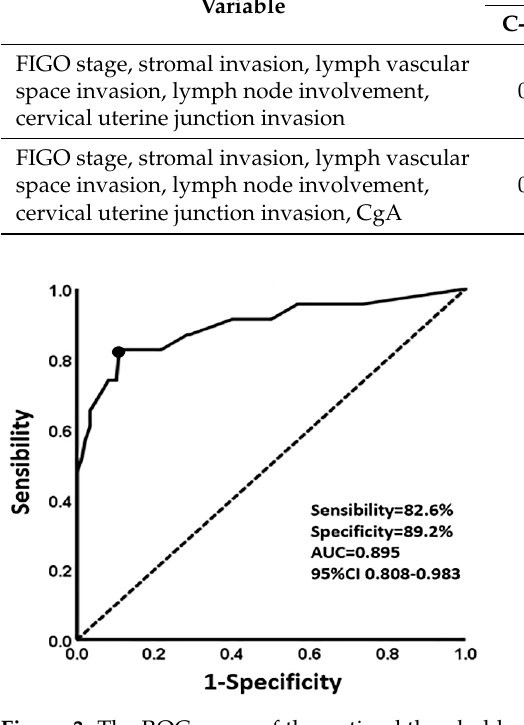
Figure 3. The ROC curve of the optimal threshold of 3 – year recurrence-free survival based on the established nomogram model. (Black dot: the area under the curve (AUC) at this point is the largest, which indicates the optimal threshold value of the 3-year recurrence-free survival predicted by the model is 0.85 (sensitivity, 82.6%; specificity, 89.2%; area under the curve = 0.895; 95% CI 0.808–0.983). Dotted line: reference line. Solid line: the ROC curve of the established nomogram model).